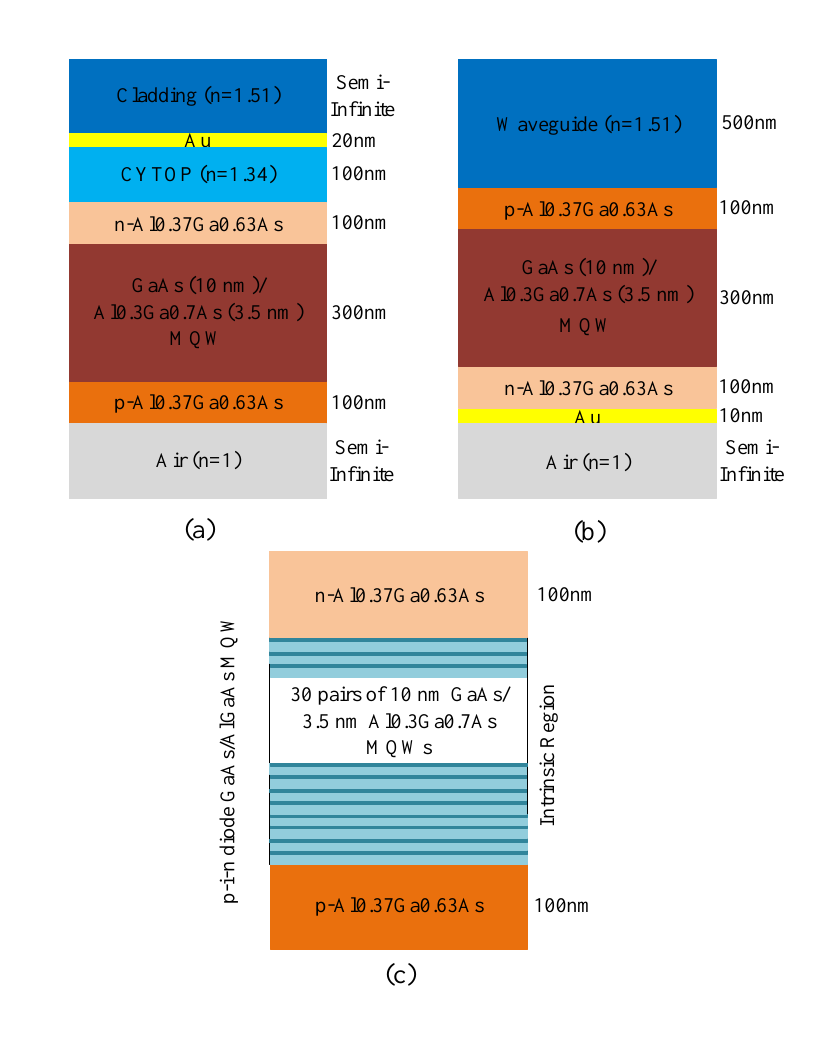
Figure 3. ( a ) The gold layer is at the interface between the optical and electronic sections. TM polarization has been exploited for MQW plasmonic hybrid modes. ( b ) The gold layer is used at the bottom of p-i-n diode for better reflectance. In this case, TE polarization has been applied. ( c ) The structure of p-i-n diode is suitable and acceptable in both